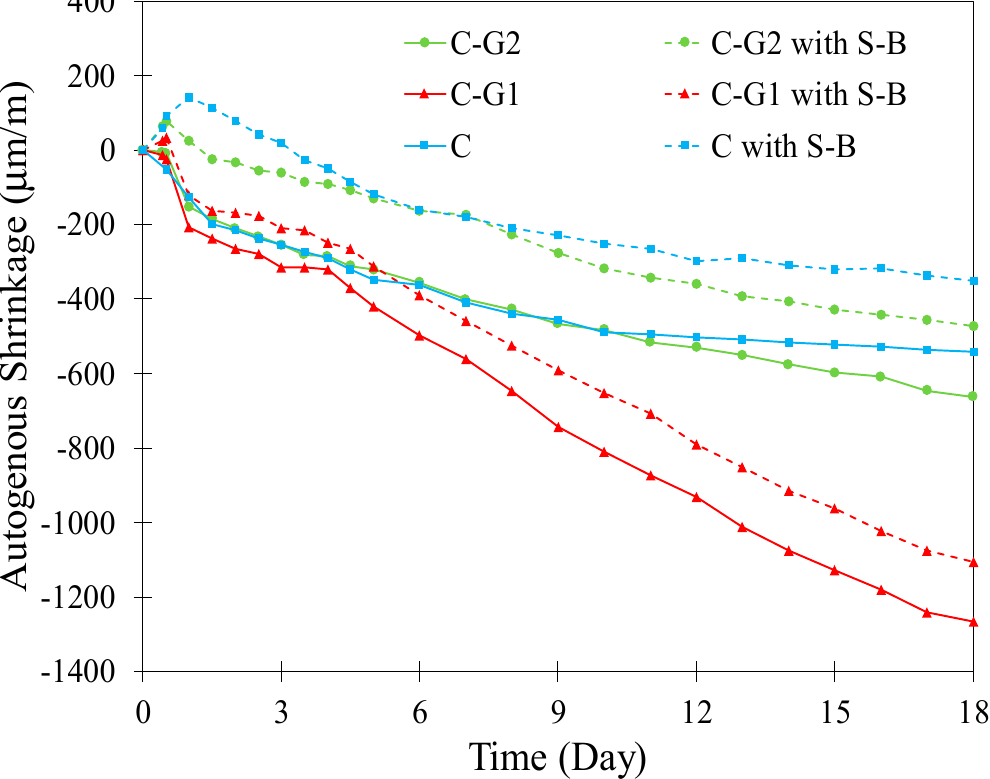
Figure 6. Autogenous shrinkage of different pastes with and without S-B.